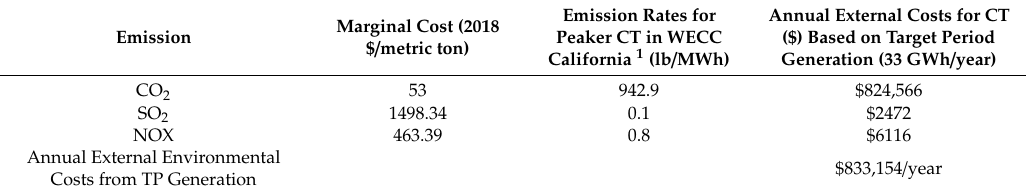
Table 6. External environmental costs of non-baseload generation plant operation based on marginal damage